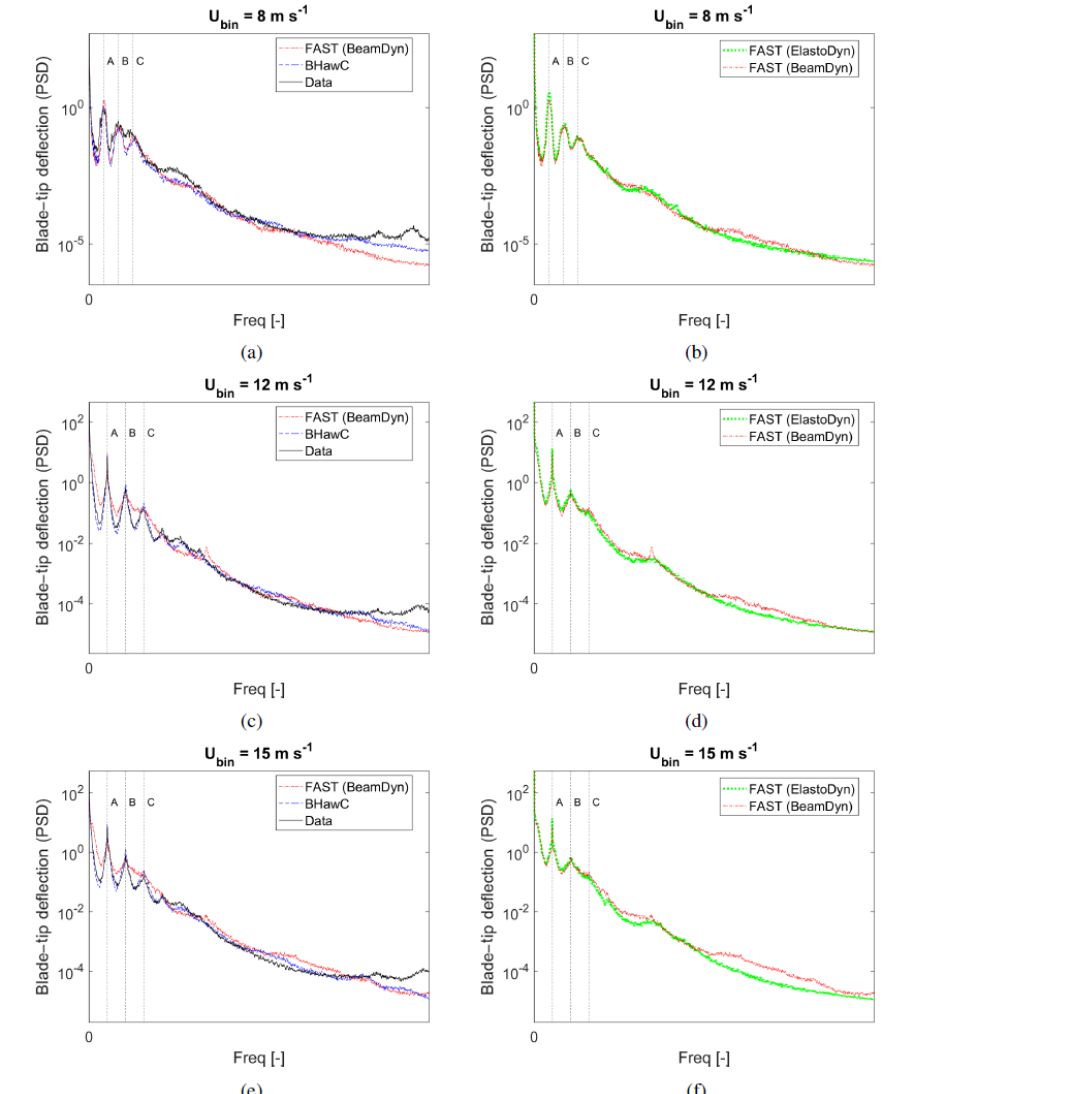
Figure 16. PSDs of the out-of-plane blade-tip deflection. The three sets of graphs represent the ensemble-averaged PSDs from the inflow velocity bins at 8ms − 1 (top), 12ms − 1 (center), and 15ms − 1